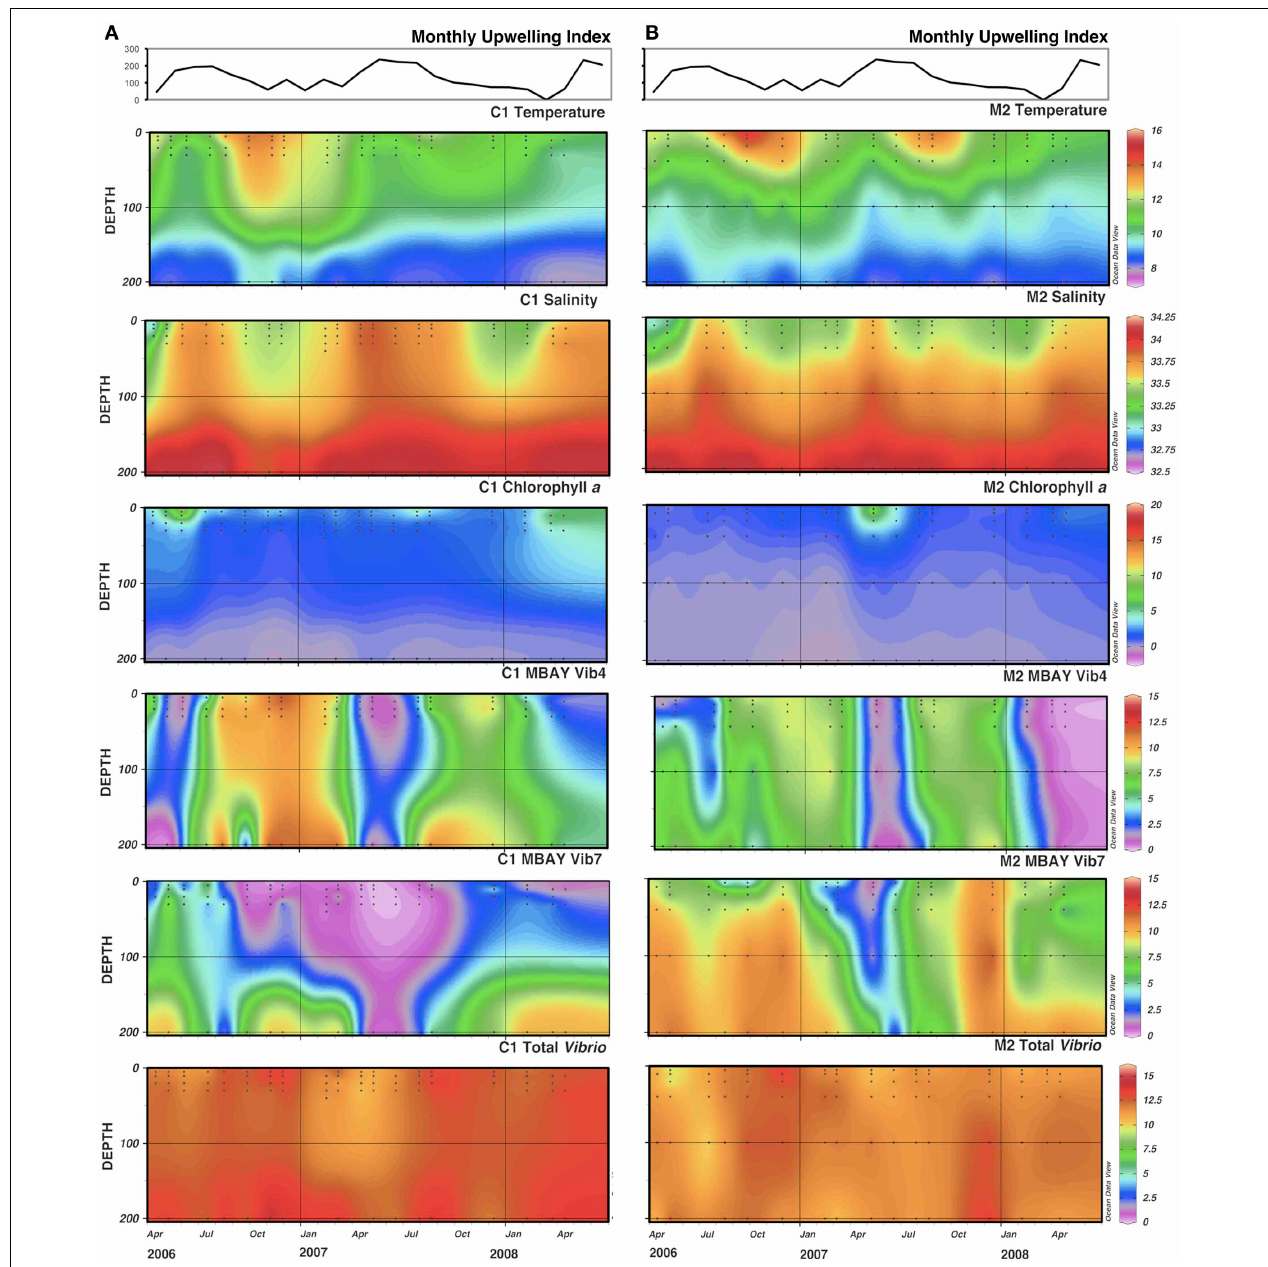
FIGURE 4 | Monthly Upwelling Index (m 3 s- 1 100m of coastline- 1 ), temperature ( ◦ C), salinity (ppt), chlorophyll a ( μ g m − 3 ) and total Vibrio , MBAY Vib4 andMBAYVib7concentrations(naturallogofgenecopiesliter − 1 )forstationsC1(A)andM2(B).